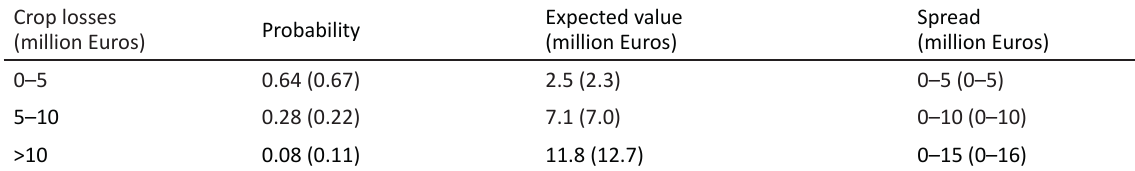
Table 4. Annual indemnity payments from farm-based insurance subdivided into layers (in parentheses, results if loss correlations from the CDC scheme are used)